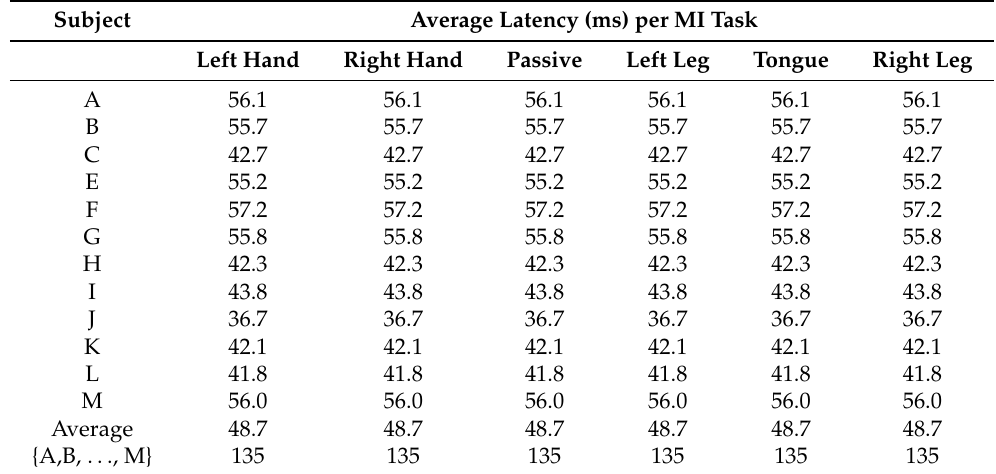
Table 11. Summary of average latency per subject for classifying each MI task.